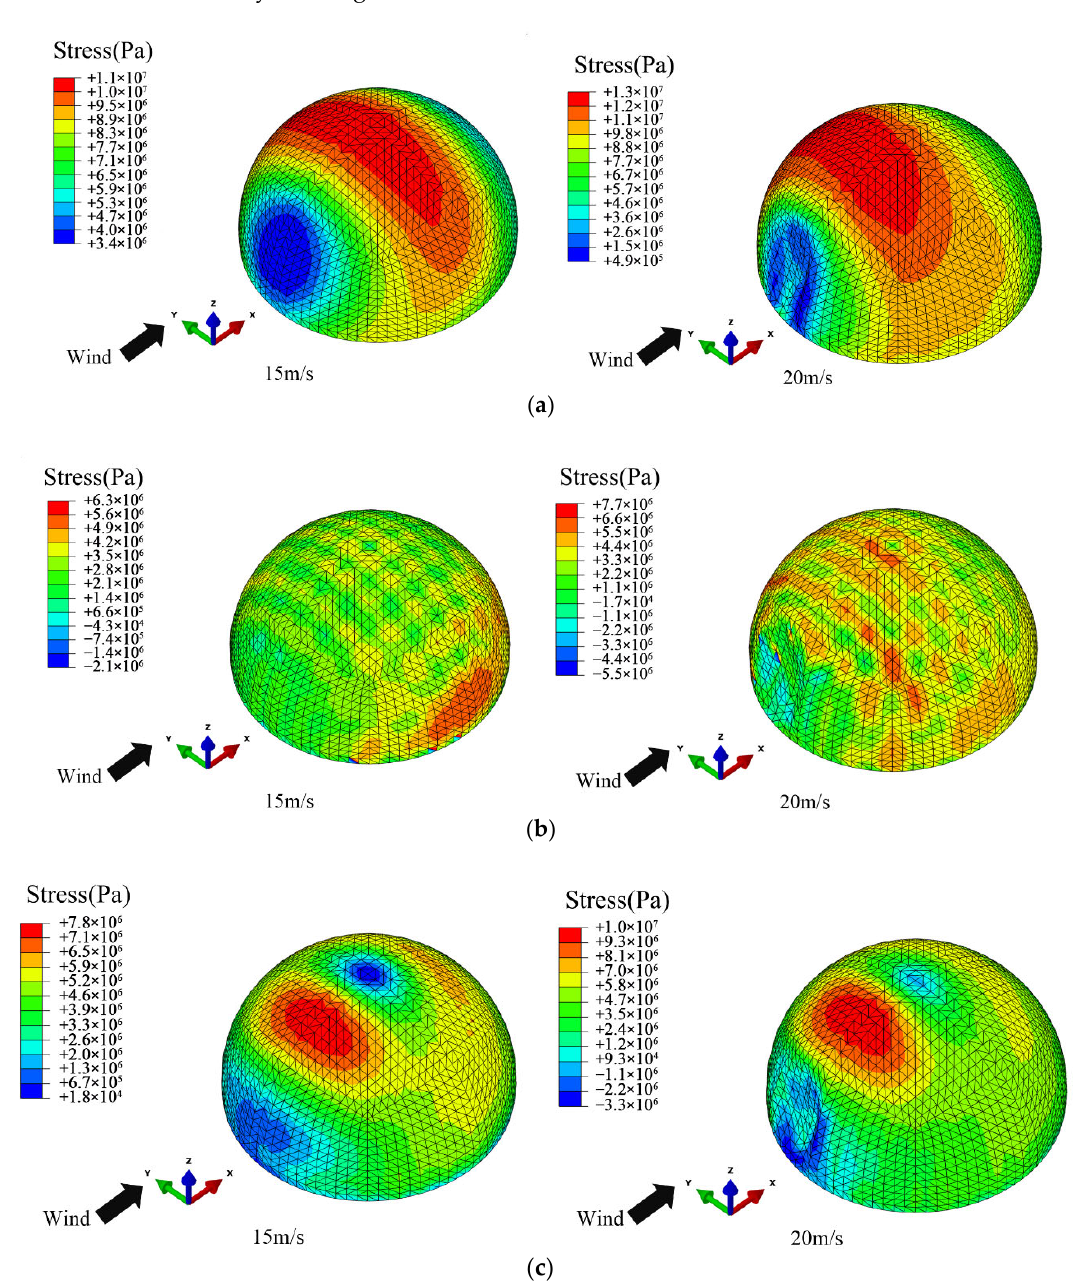
Figure 19. Contours of maximum membrane stress of structures with different cable configurations ( L = 60 m, H / L = 0.50, p = 300 Pa): ( a ) Without cables; ( b ) Cross cables; ( c ) Radial cables.